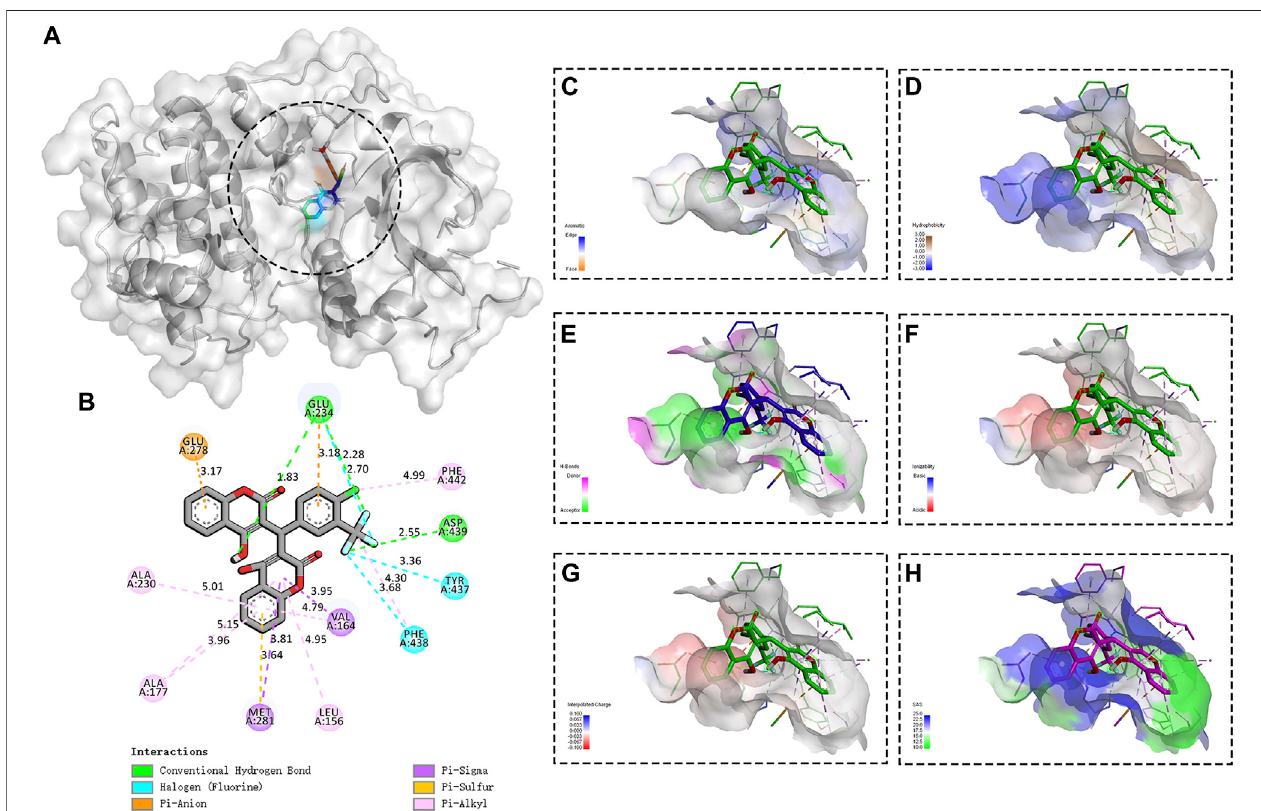
FIGURE 6 | Binding site and model of N6 with AKT1 (A) Overview of the docked pose between the N6 and binding pocket to the active site of Akt1 (B) The close view of the interaction between N6 and the active site of Akt1 (C) In the analyzed result of the aromatic ring edges or faces, the negative values (blue) correspond to the edges of aromatic rings, whereas the positive values (orange) correspond to the faces of aromatic rings (D) In the analyzed result of the hydrophobicity, the negative values(blue)correspondtohydrophilicresidues,whereasthepositivevalues(brown)correspondtohydrophobicresidues (E) Intheanalyzedresultofthehydrogen bond, the negative values (green) correspond to hydrogen bond acceptors, whereas the positive values (magenta) correspond to hydrogen bond donors (F) In the analyzed result of the ionizability, the negative values (red) correspond to acidic residues, whereas the positive values (blue) correspond to basic residues (G) In the analyzed result of the atomic charge, values less than − 0.1 are mapped in red, and values larger than +0.1 are mapped in blue (H) In the analyzed result of the solvent accessibility surface, small values (green) correspond to buried residues, whereas large values (blue) correspond to exposed residues.